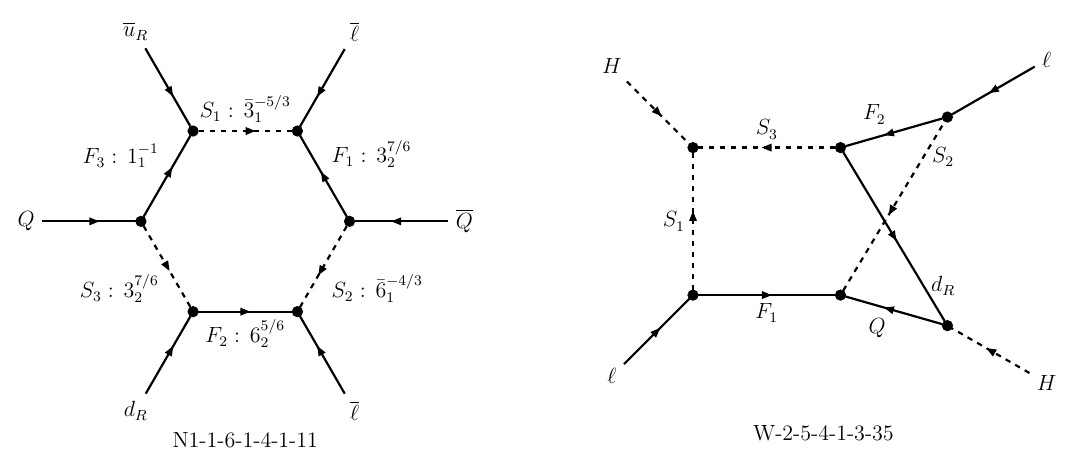
Figure 10 . An example of 0 νββ decay model N1-1-6-1-4-1-11 (left panel) with the hypercharge parameter α = − 4 , which is a UV completion of the operator N1 based on the diagram N-1-6-1. 3 The neutrino masses arise from the two-loop diagram W-2-5-4-1-3-35 (right panel) at leading order, and it is mediated by the messenger fields of the model